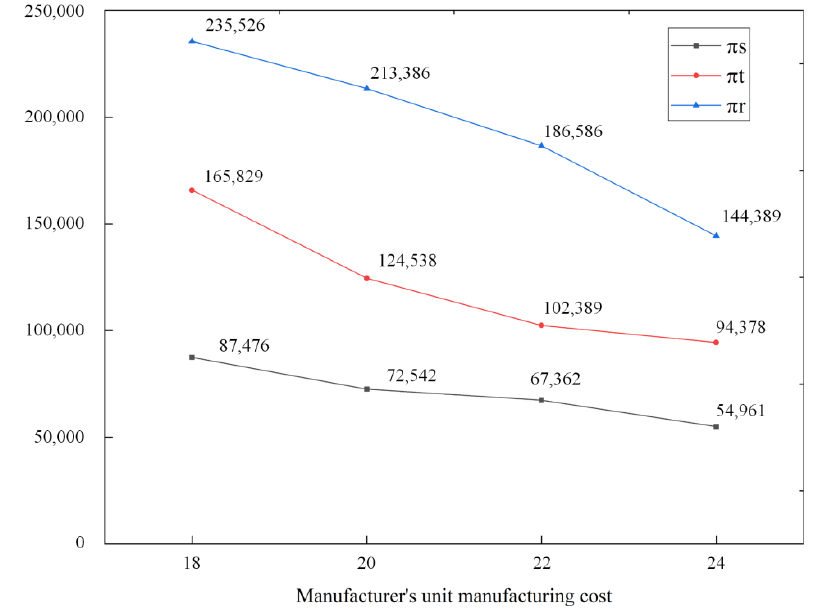
Figure 7. The impact of the manufacturer’s unit manufacturing cost on the profits of all parties in the supply chain.